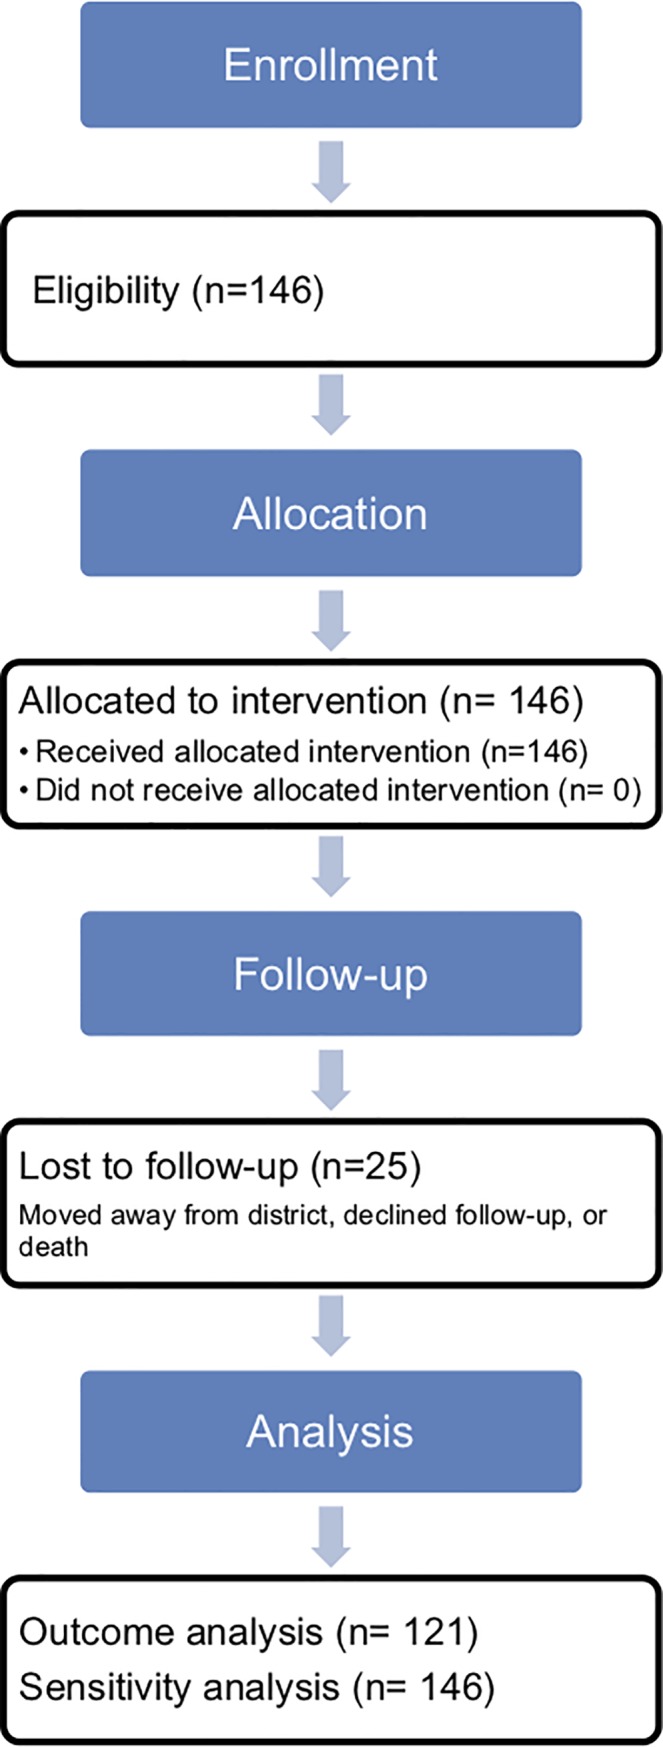
Enrollment flow diagram, MESH MH evaluation.